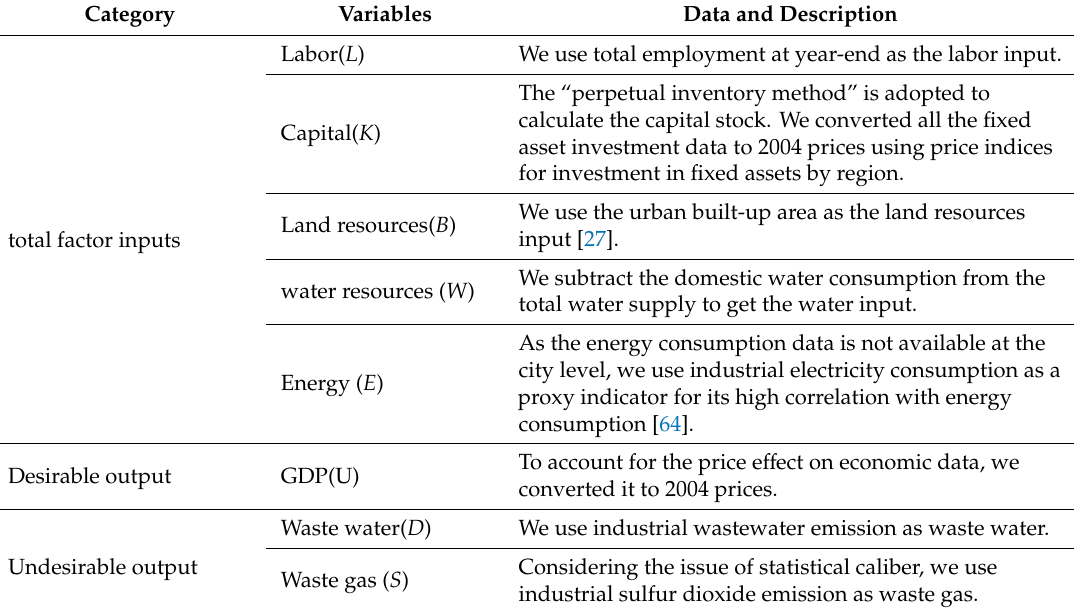
Table 1. Input-output variables and data